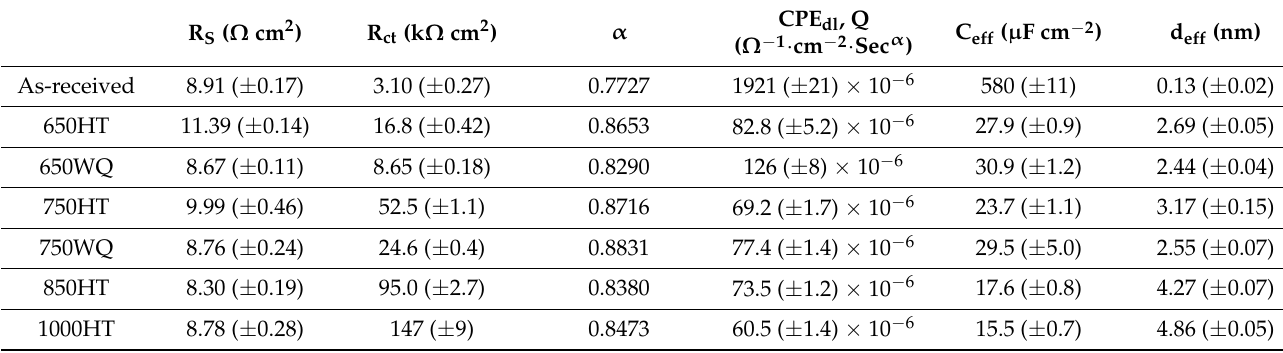
HT: furnace cooling; WQ: water